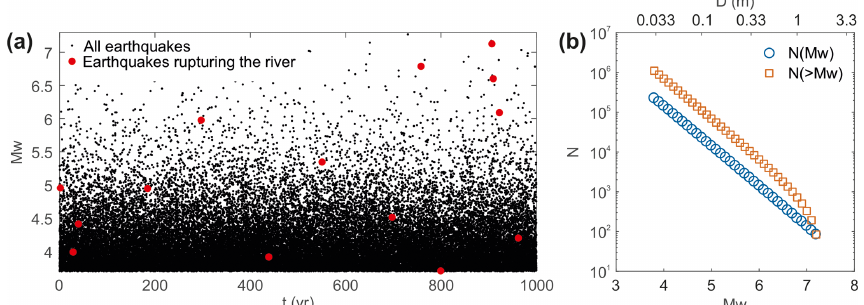
Figure 2. Modelled seismicity and its statistical characteristics. (a) Time distribution t of the magnitude M w of earthquakes during the first 1000 years of one model. Both mainshocks and aftershocks are shown with black dots. Earthquakes with rupture zone extending to the surface and cutting the river, located at the middle of the fault trace, are shown with red dots. (b) The cumulative (light red squares) and incremental (light blue circles) Gutenberg–Richter frequency–magnitude distribution of earthquakes for one model. N is the number of events and D is the associated displacement computed using the Leonard (2010) scaling law.